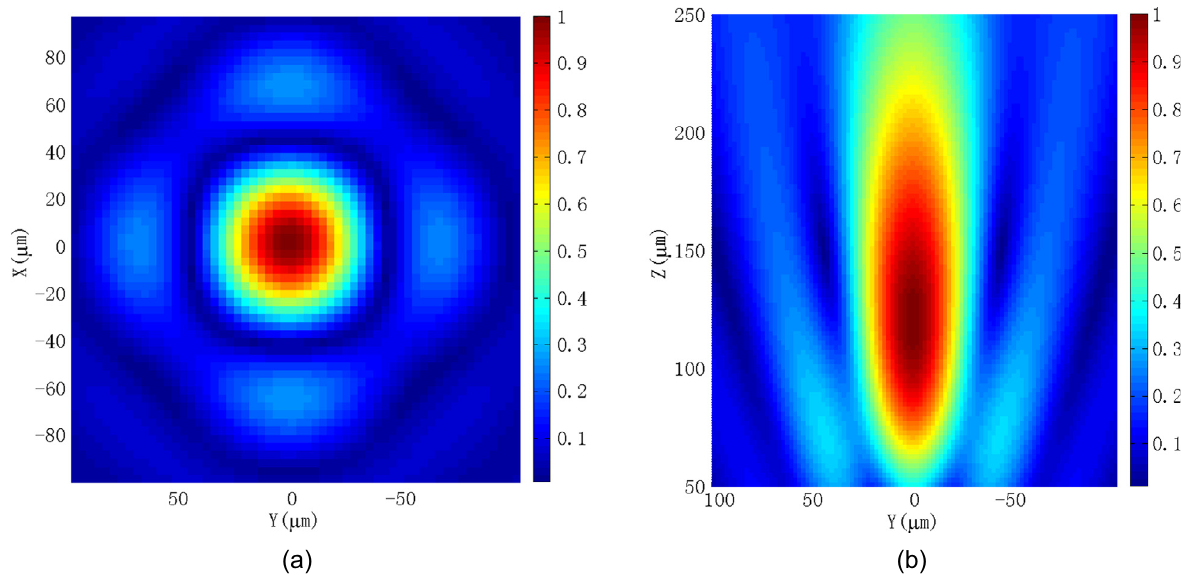
Figure 12. (a) Normalized complex magnitude of E-field on the X - Y plane, (b) normalized complex magnitude of E-field on the Y - Z plane.